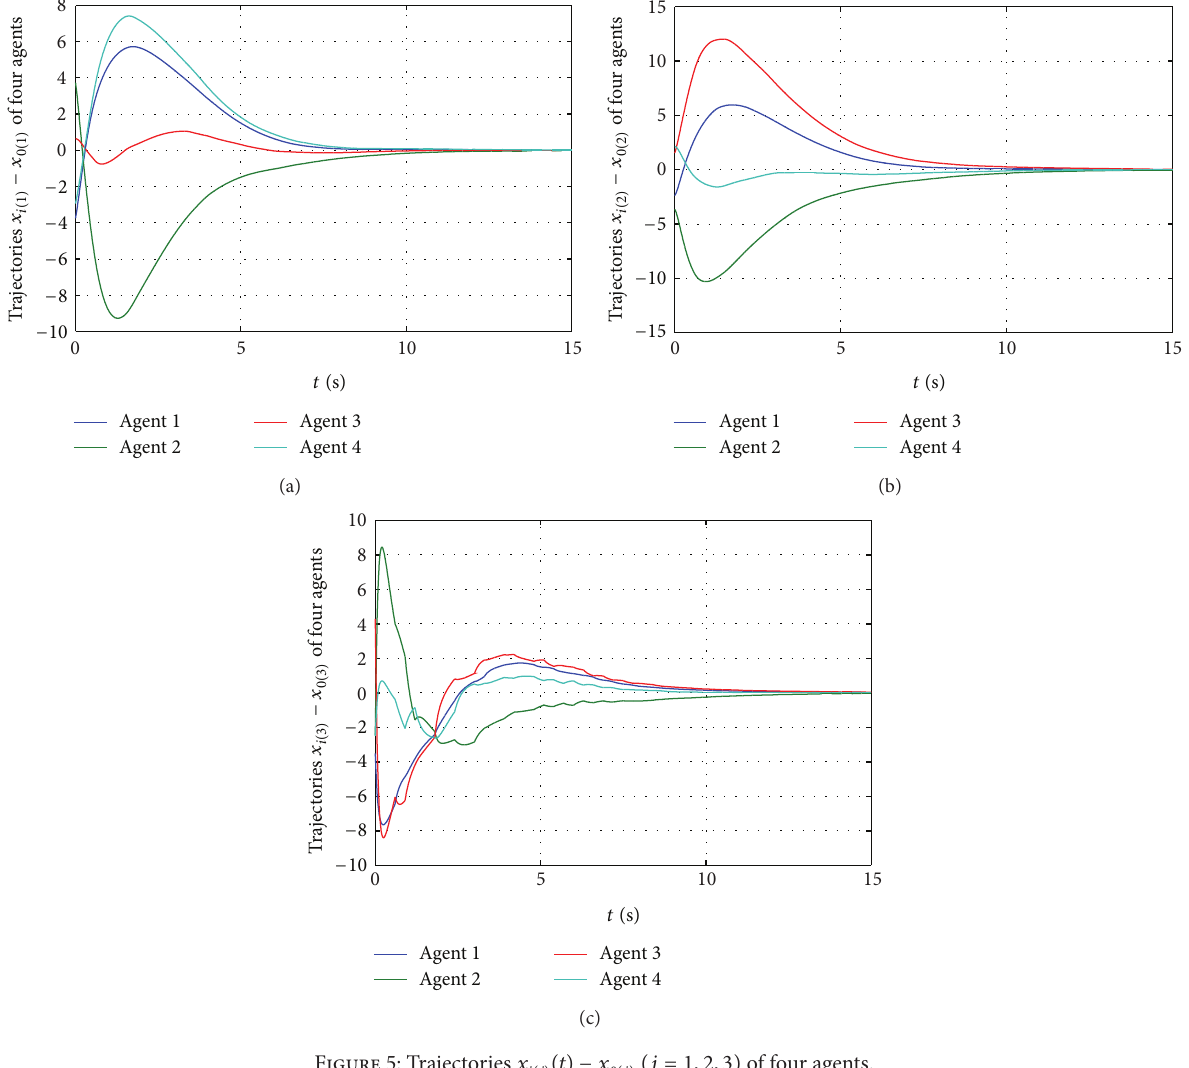
Figure 5: Trajectories 𝑥 𝑖(𝑗) (𝑡) − 𝑥 0(𝑗) ( 𝑗 = 1, 2,3 ) of four